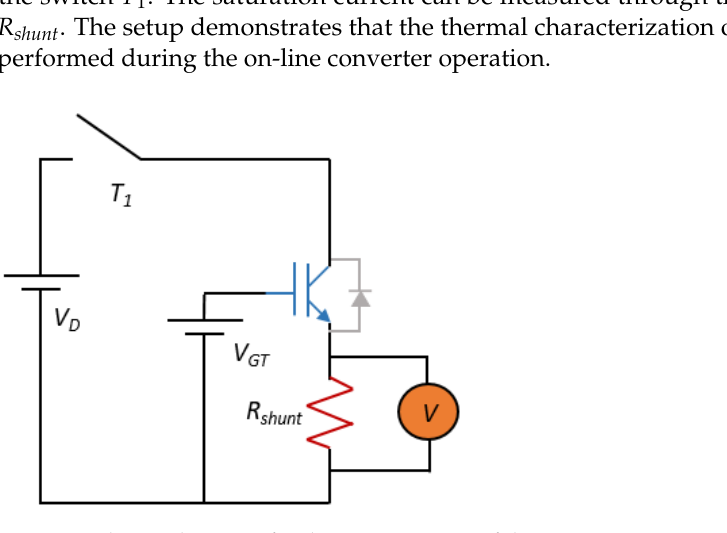
Figure 9. Electrical circuits for the measurement of the saturation current in an IGBT device.